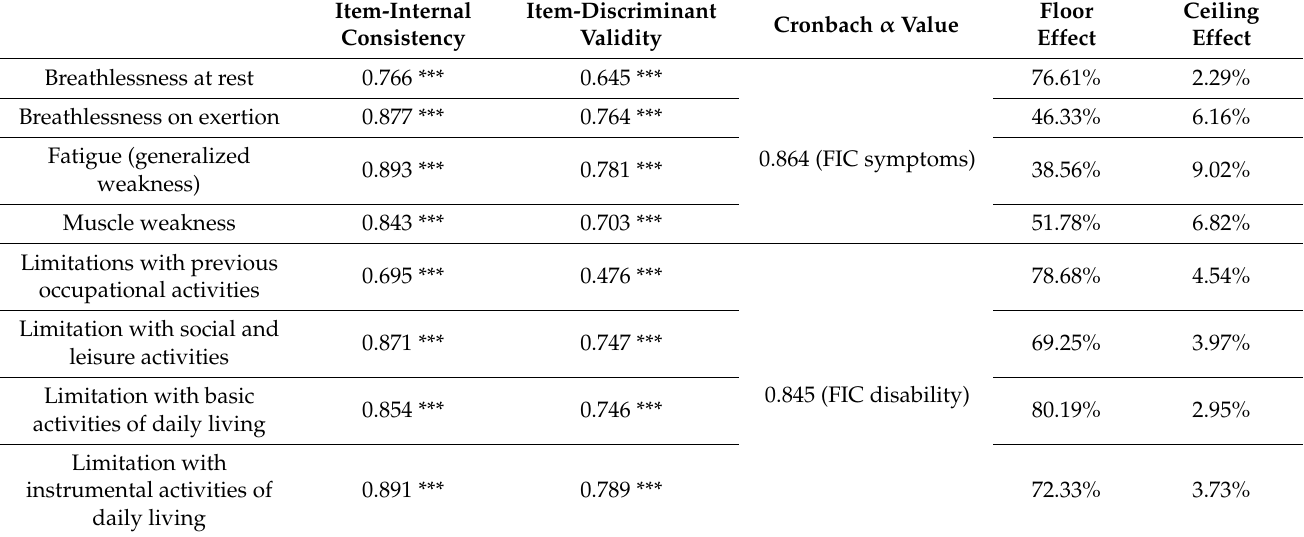
Table 2. Internal Consistency, Discriminant Validity and Floor and Ceiling Effect of each item of the Functional Impairment Checklist (FIC) in COVID-19 survivors experiencing long-COVID. Item-Internal Consistency